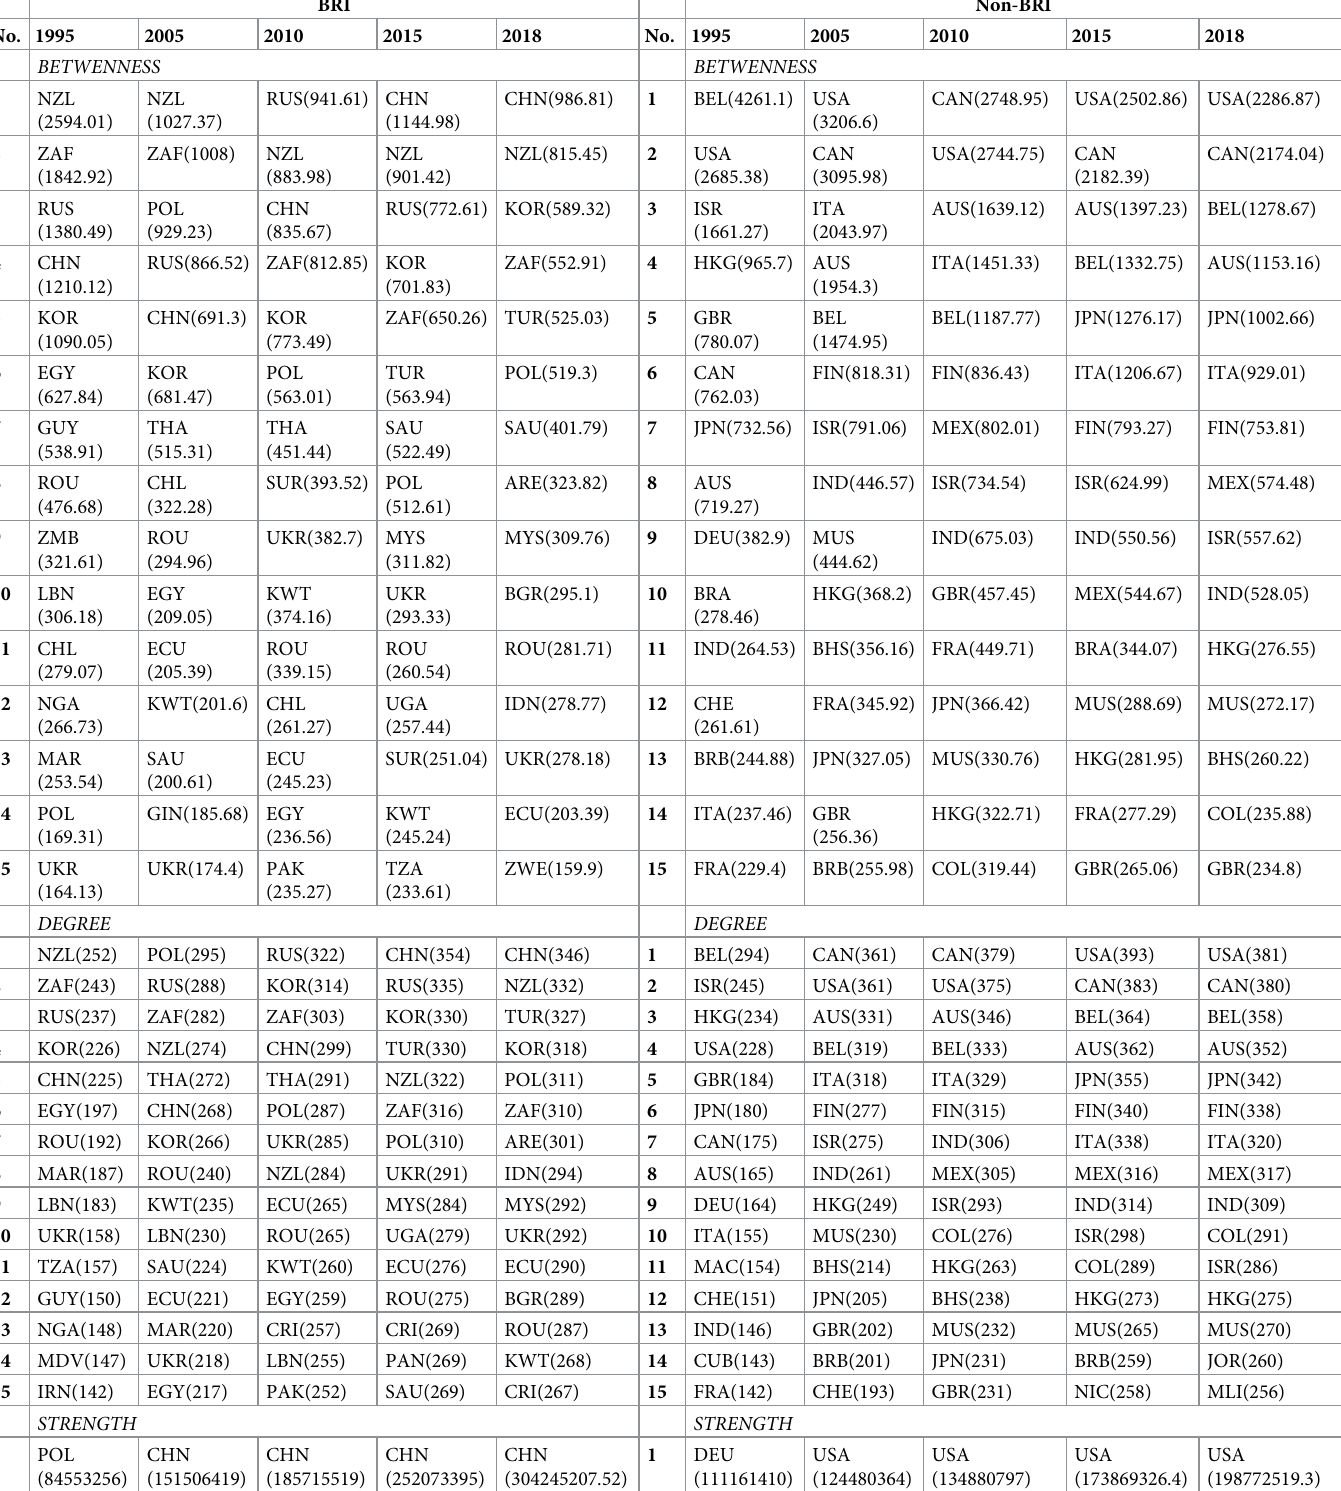
Table 2. Centrality properties of BRI and non-BRI groups.